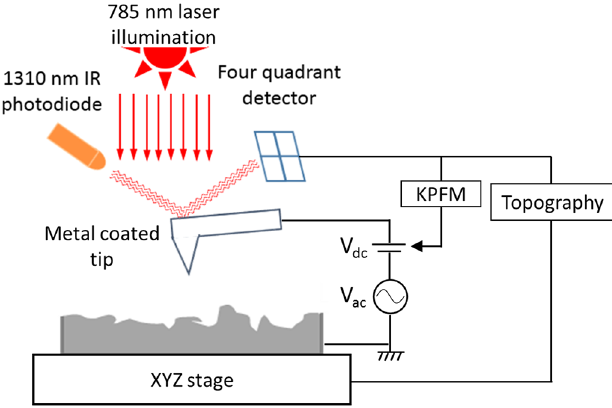
Fig. 1. Kelvin probe force microscopy setup schematic. The conducting cantilever carrying the KPFM tip is scanned over a surface while AC+DC potential is applied. The AC signal is a sinusoid whose frequency matches the mechanical resonance of the cantilever. The four-quadrant detector provides feedback in order to minimise cantilever oscillation by varying the DC signal thereby yielding the sample work function compared to the tip